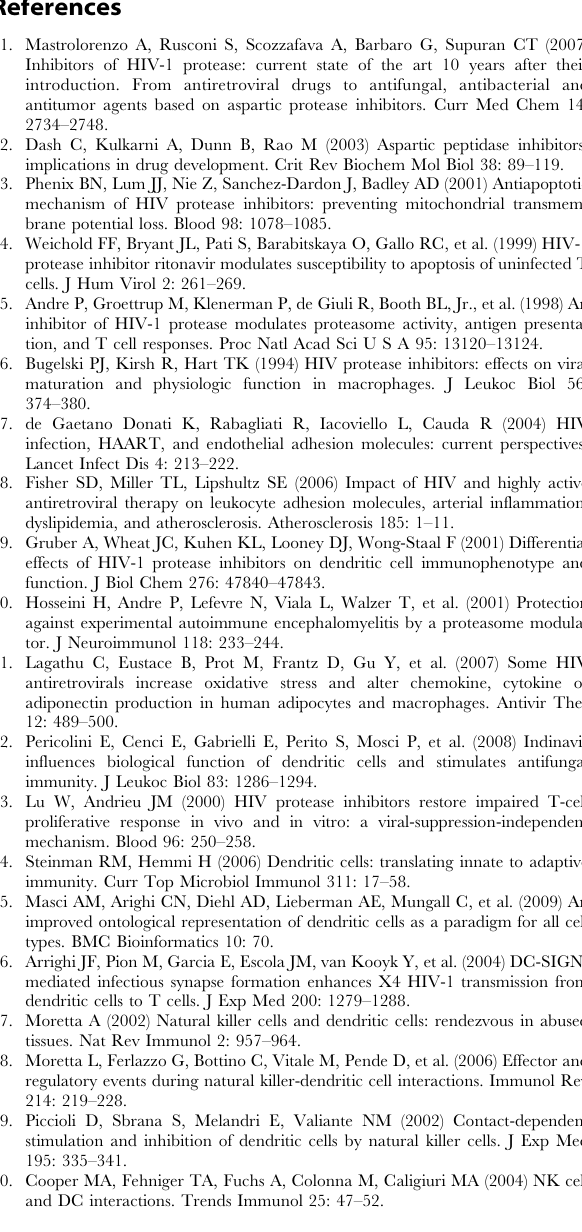
Figure S3 Expression of NKp30 and NKG2D ligands on mDC generated from monocytes differentiated in the presence or absence of PIs. iDC generated in the presence or absence of 20 m M rtv or apv were extensively washed and cultured with 1 m g/ml LPS to induce terminal differentiation. After 24 hours, cells were collected and stained for NKp30 ligands (A) or NKG2D ligands (B). Bar graphs reports average and standard deviation of three independent